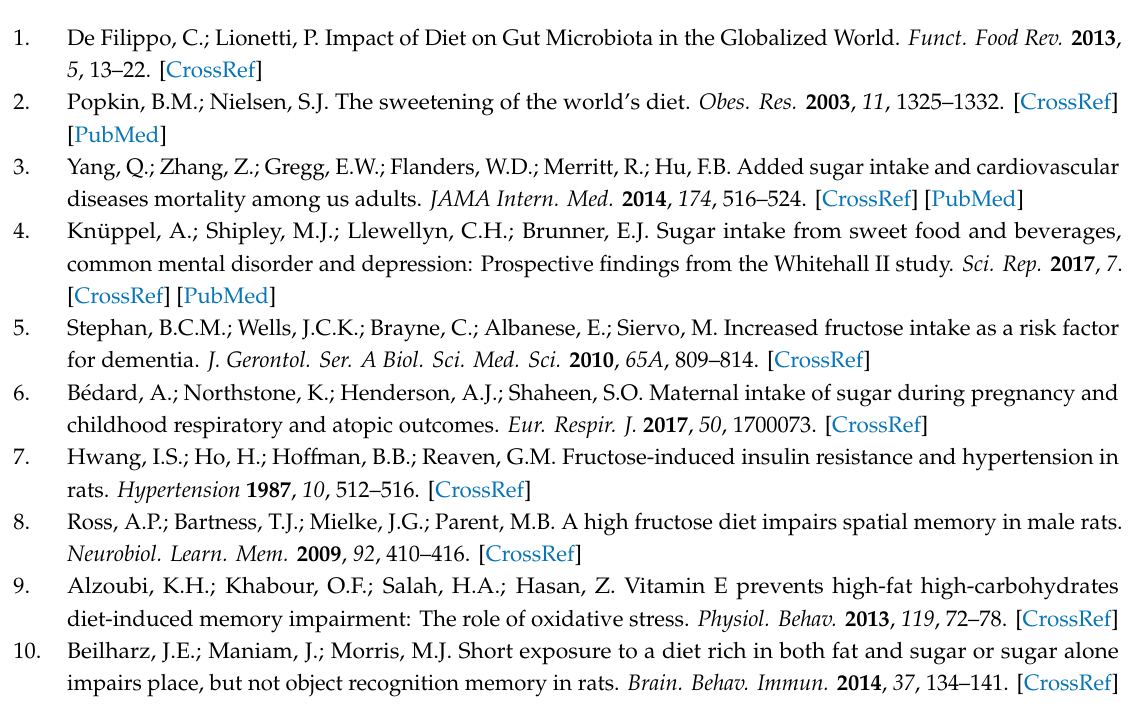
Figure S1: Experimental scheme, Figure S2: Gating strategy for flow cytometry analysis of innate immune cells, Figure S3: Gating strategy for flow cytometry analysis of T cells and innate lymphoid cells 3 (ILC3), Figure S4: The mRNA expression of Nos2 (iNos), Tgfb1, Lcn2 (lipocalin 2), and Il17f in colon of healthy mice, Figure S5: The mRNA expression of Nos2 (iNos), Tgfb1 , Lcn2 (Lipocalin 2) and Il17f in colon of mice su ff ering acute DSS colitis, Figure S6: Simple sugars significantly increase intestinal permeability and promote local and systemic pro-inflammatory tuning in healthy RAG2 − / − mice, Figure S7: The mRNA expression of pattern recognition receptors dectin 2 ( Clec4n ) and toll-like receptor 4 ( Tlr4 ), NF- κ B pathway regulators IRAK-3 ( Irak3 ) and NF-kappa-B inhibitor zeta ( Nfkbiz ), and gut barrier proteins ZO-1 ( Tjp1 ) and occludin ( Ocln ), Figure S8: Prediction of metabolic pathways. PICRUSt analysis was used to associate microbiota abundances with metabolic pathways in mice feces, Figure S9: Protective e ff ect of HFiD in acute colitis is not transferred by microbiota alone, Figure S10: Inflammatory response in TLR4-deficient mice, Figure S11: Inflammatory response in TLR4 deficient mice, Table S1: Main components of the diets, Table S2: Metabolized energy of the diets, Table S3: Saccharide content, Table S4: Fluorochrome-labeled antibodies used for flow cytometry, Table S5: PCR primers used for gene expression analysis by quantitative